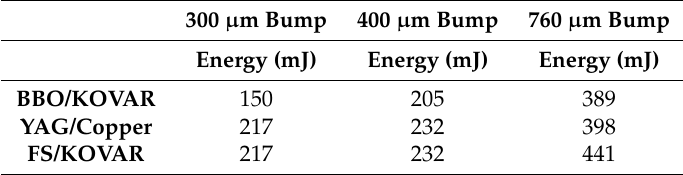
Table 2. Solderjet Bumping energy necessary to reflow and melt the spherical preform alloys of different sizes for subsequent bonding of the different combinations of optical and substrate